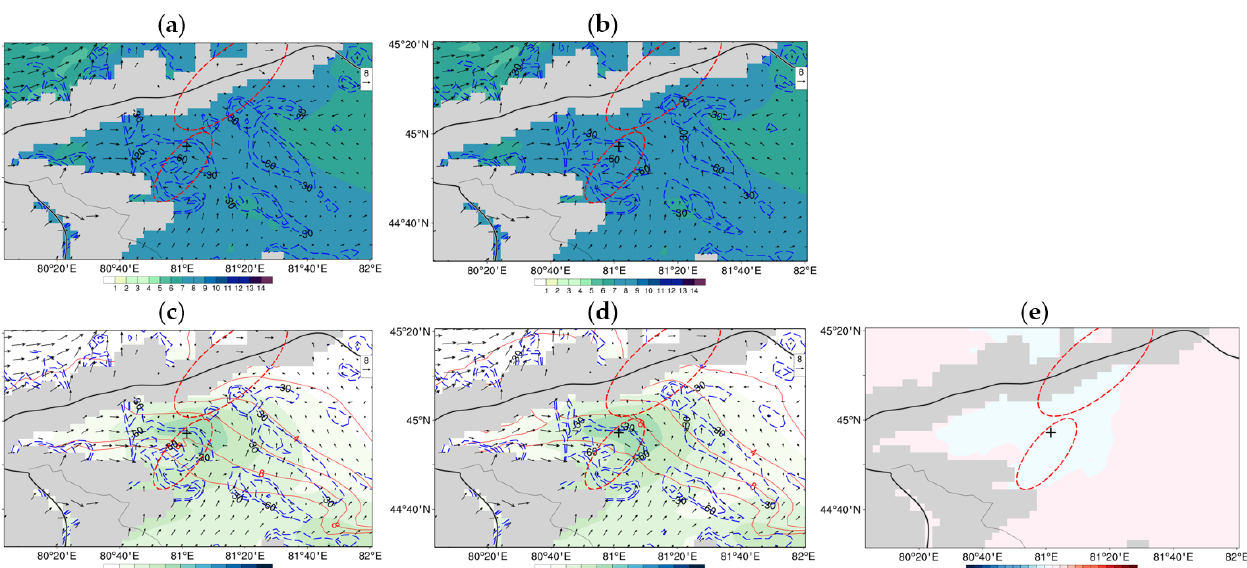
Figure 9. Vertical cross-section of the analysis and the increment of water vapor (unit g/kg) along line CD at 0800 UTC. ( a ) The analysis from C2Rad. ( b ) The analysis from C2RadBy. ( c ) The increment from C2Rad. ( d ) The increment from C2RadBy. ( e ) The difference of increment between C2Rad and C2RadBy. The shades in each plot indicate the water vapor mixing ratio (unit g/kg). The solid red lines indicate the increment of temperature (unit 0.001 °C). The dashed blue lines indicate negative divergence (unit 1/s).